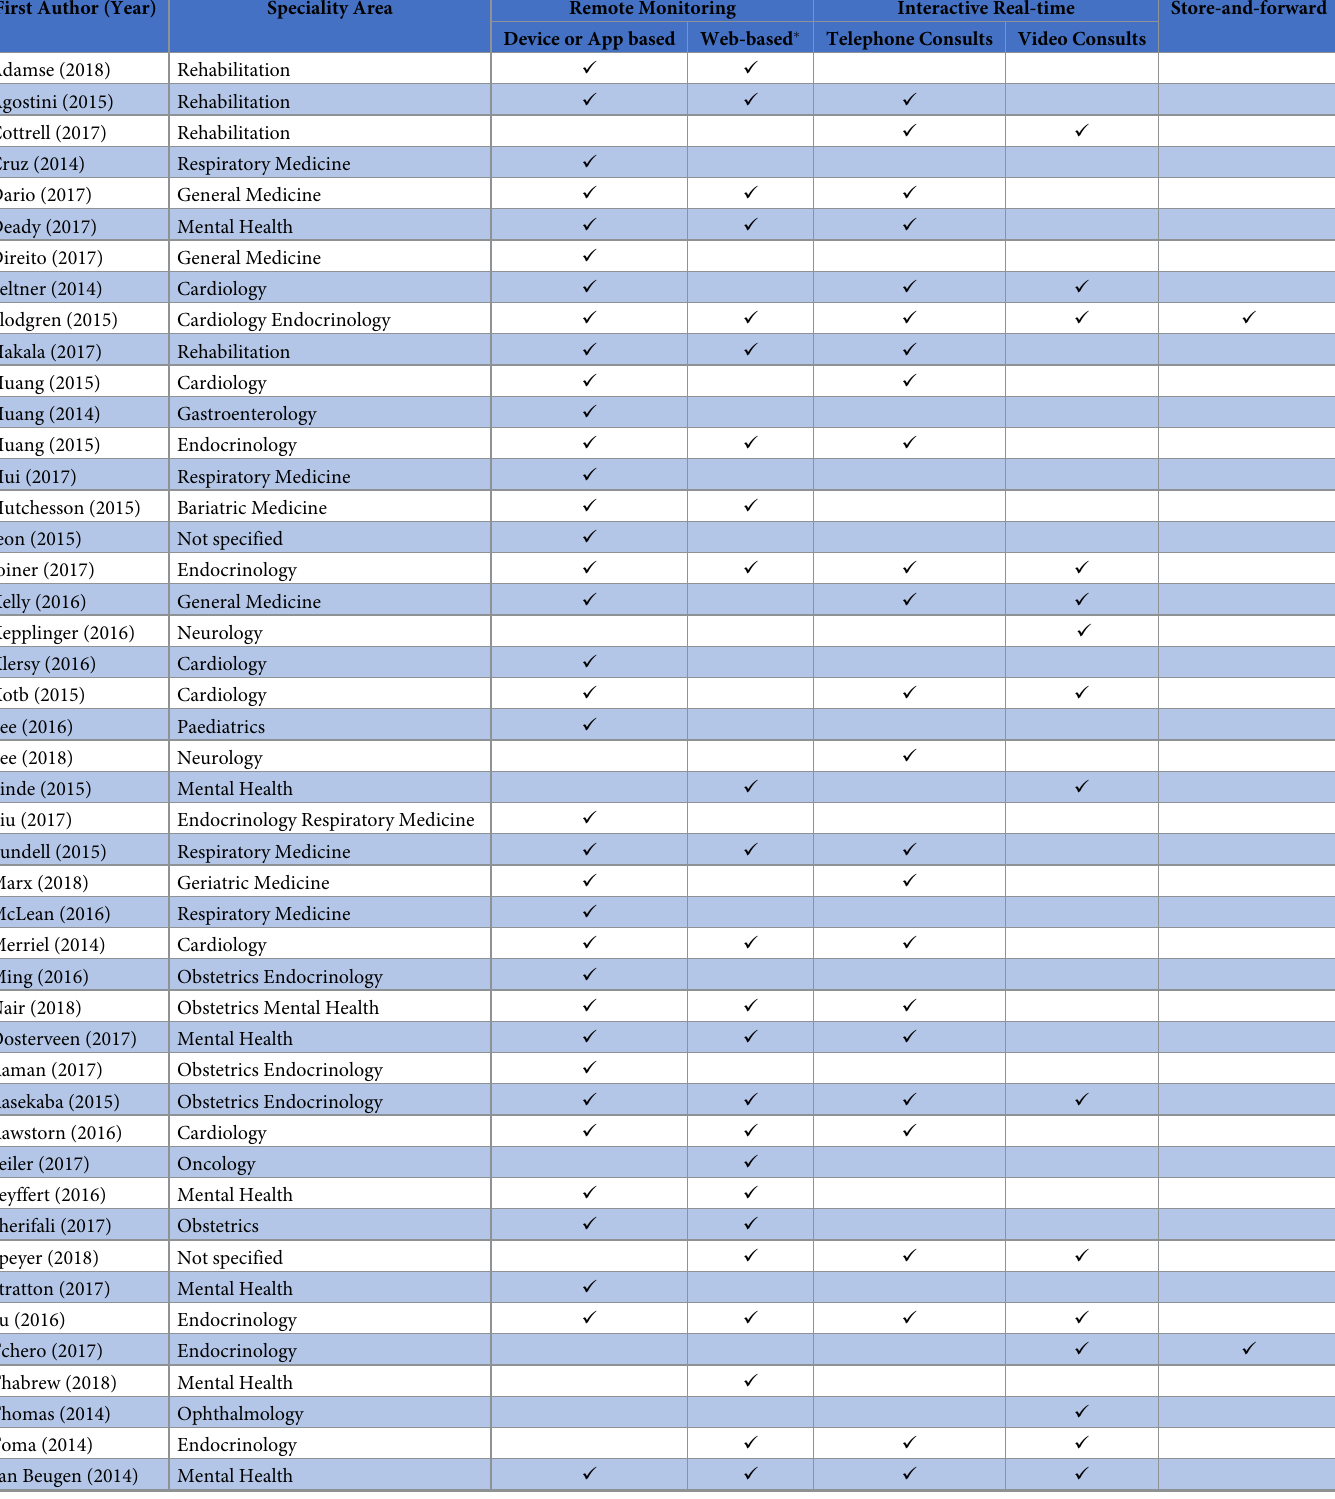
Table 2. Effectiveness reviews by speciality area and type of telemedicine